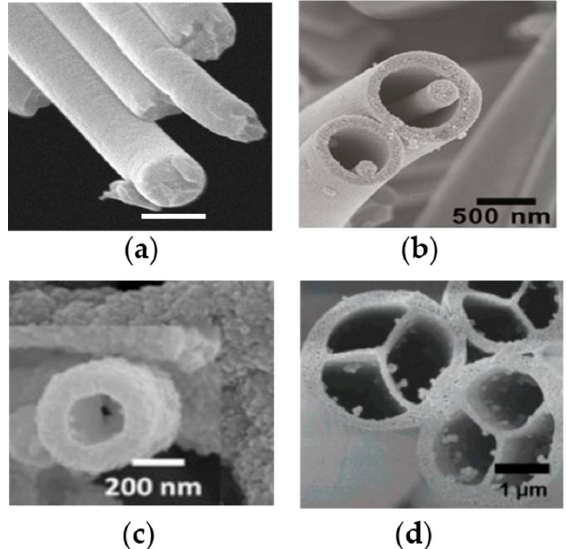
Figure 9. Figure 9. SEM images of various structural nanofibers: ( a ) single nanofibers, ( b ) core–shell nanofibers [125] (Copyright 2010, American Chemical Society); ( c ) hollow nanofibers [126] (Copyright 2017, Elsevier) and ( d ) islands-in-the-sea nanofibers [124] (Copyright 2007, American Chemical Society).